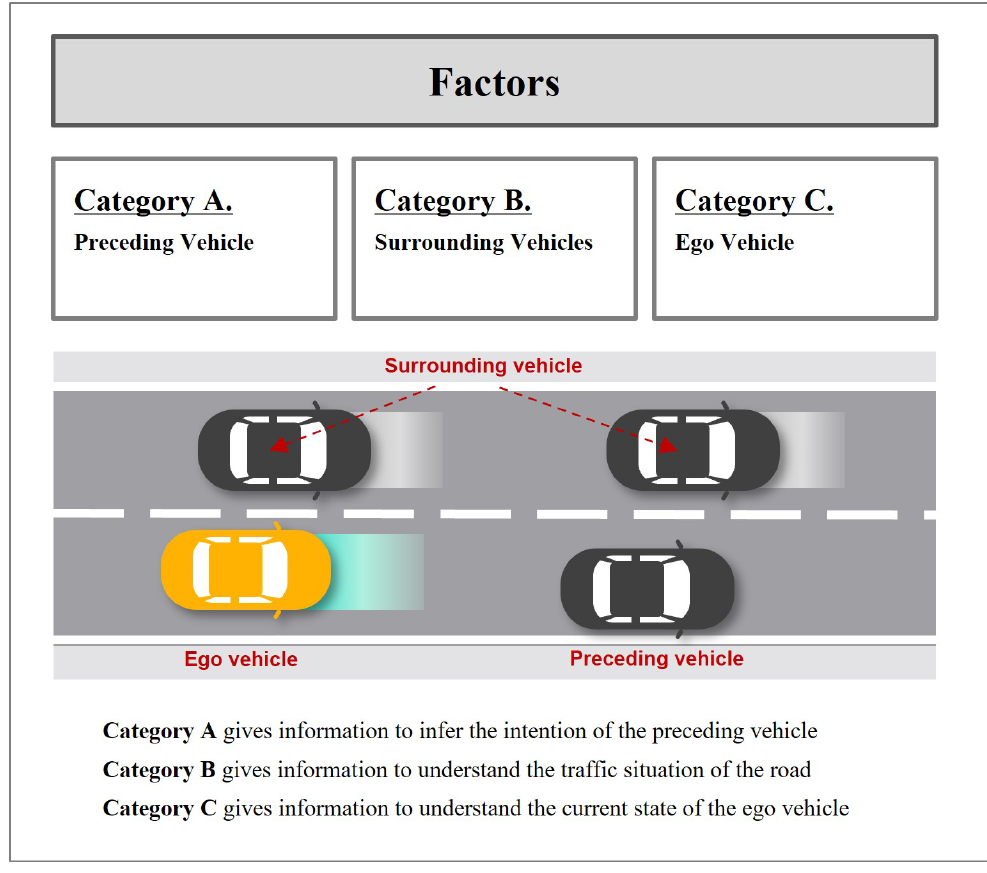
Figure 4. Categorization of the